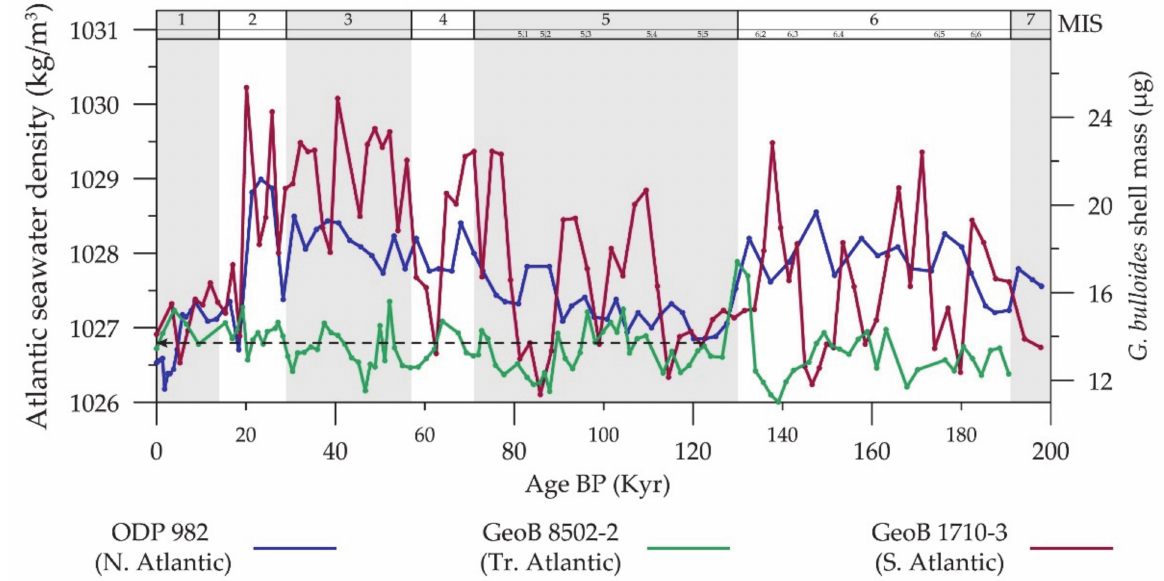
Figure 3. Atlantic Ocean density reconstructions for the last 200 kyr based on planktonic foraminifera shell weights from three different sites. Note the convergence in seawater density/planktonic foraminifera shell mass values for two instances in the records and how these values match the modern seawater densities. Table 2. Summary of G. bulloides shell masses and the mass-derived seawater densities for the three different Atlantic sites across the two SMCEs during the last two deglaciations. The reconstructed densities presented in the last column are geochemically reconstructed seawater densities during SMCE II published in Zarkogiannis , et al. [40] for core GeoB 8502-2.